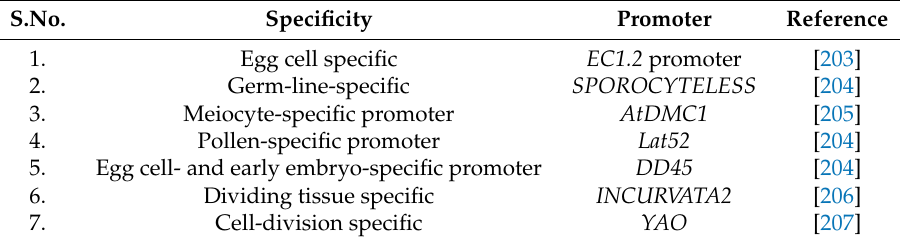
Table 3. Tissue-specific promoters which can be used in CRISPR / Cas9 technology